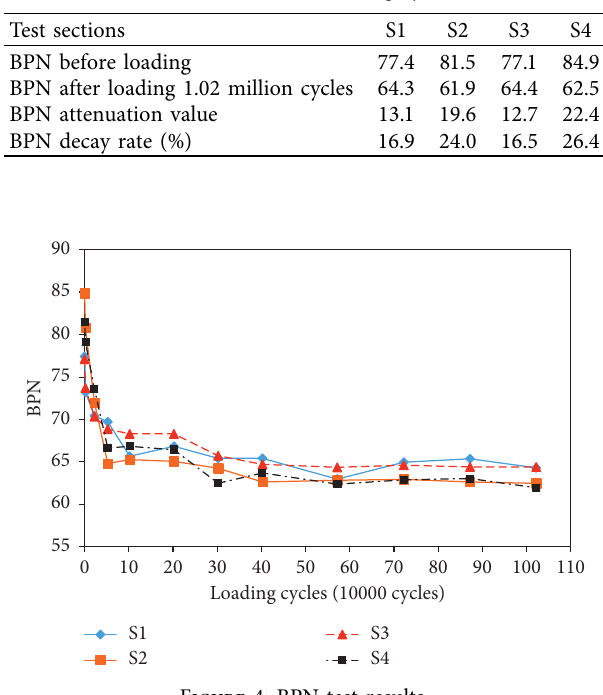
Figure 4: BPN test